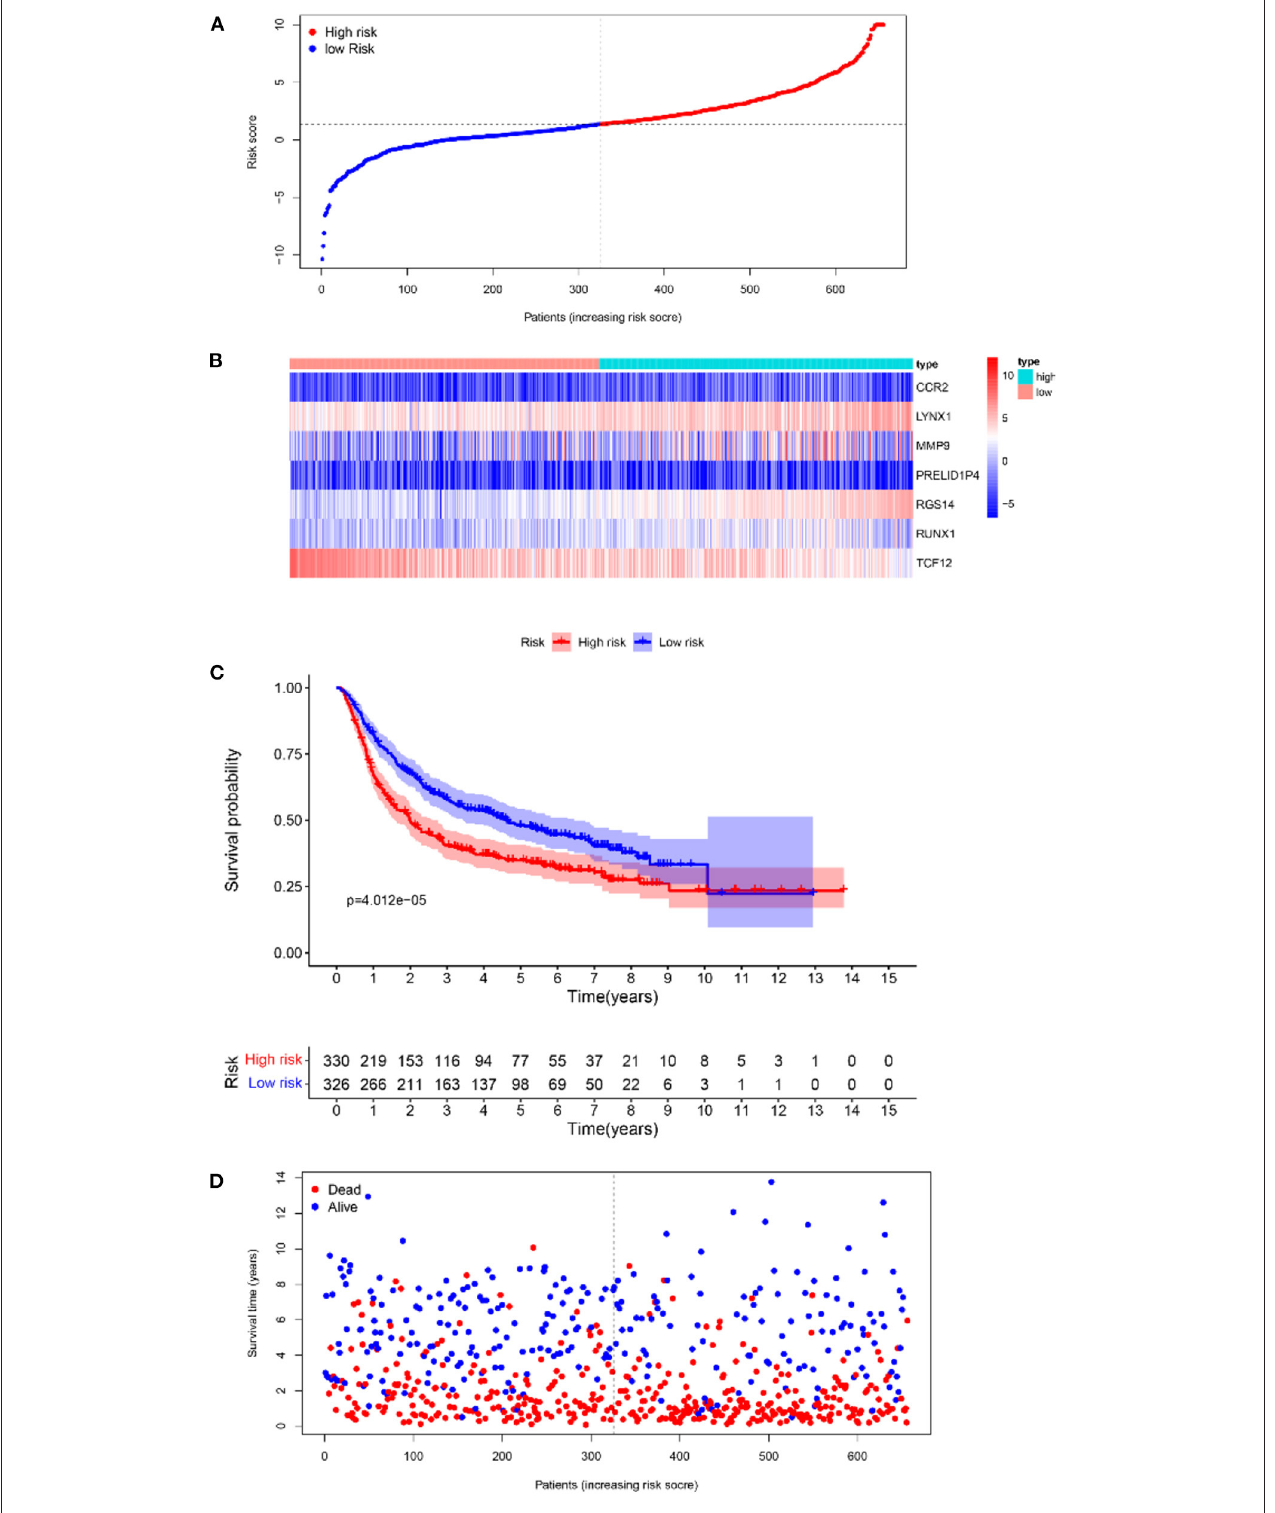
FIGURE 7 | The results of survival analysis of the prognostic model in the CGGA-GBM cohort. (A) Risk score scatter map. (B) Heat map of the differential expression level of 7 marker genes. (C) KM curves of OS in the 2 risk subgroups. (D) Survival status scatter map.